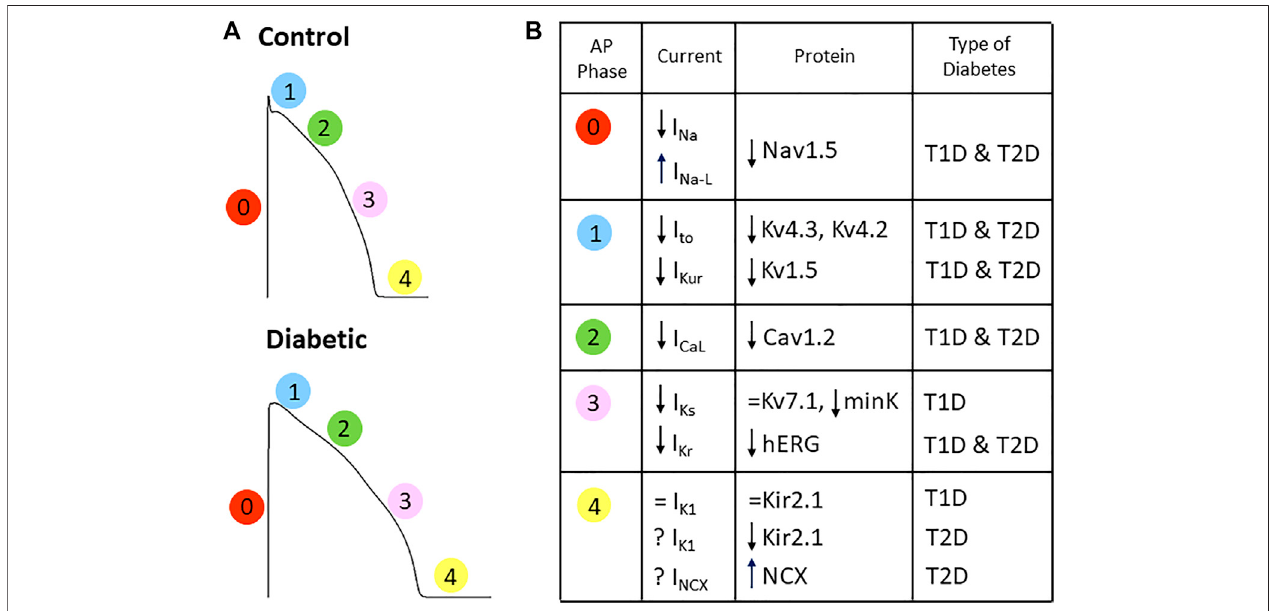
FIGURE3| Diabetesaffectsthedepolarizingandrepolarizingcurrentsresponsibleforthecardiacactionpotential. (A) Actionpotentialdepictionsofacontrolanda diabetic heart (numbers indicate the phase of the AP) showing that diabetes changes action potential shape and prolongs its duration. (B) Summary of the alterations in the cardiac ion currents and the respective channel-forming proteins obtained in animal models of TD1 and T2D. See text for references.